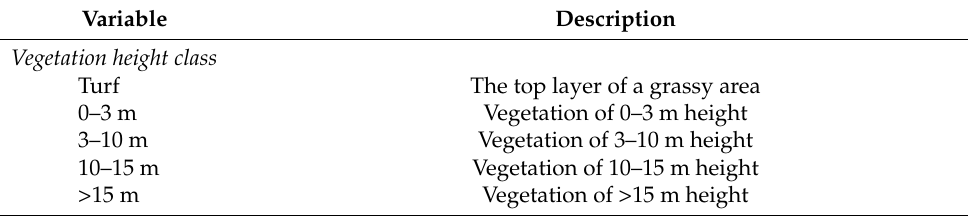
Table 4. Independent variables considered in the multivariate model of LST within golf courses and other land use categories. The MSPA descriptors are the same as published by the original workers